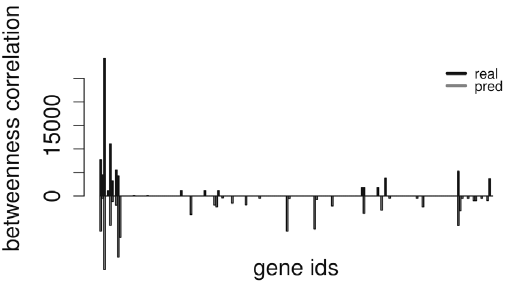
Figure 6. Betweenness correlation across real and predicted